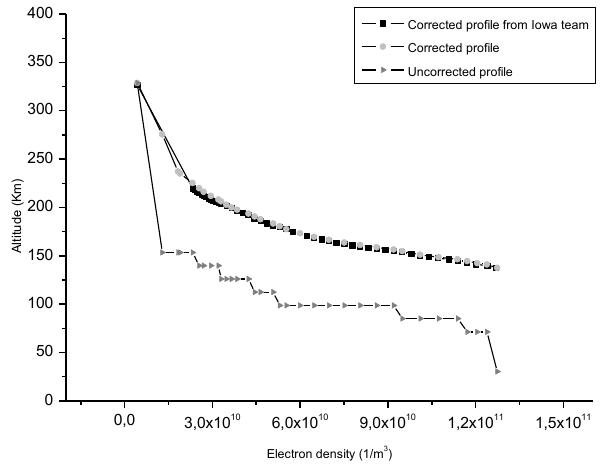
Fig. 2. Example of topside ionospheric profiles obtained from the ionogram 178 in the orbit 2405 of Mars Express. There are two different kinds of profiles: the corrected profile where the true height corrected by the oscillation harmonic in the frequency is used and the uncorrected one where the virtual height is considered. Another corrected profile, obtained at Iowa University by the MARSIS team, is also displayed. The agreement with the ionogram corrected by our team is very remarkable and confirms that the same method is applied to obtain the electron